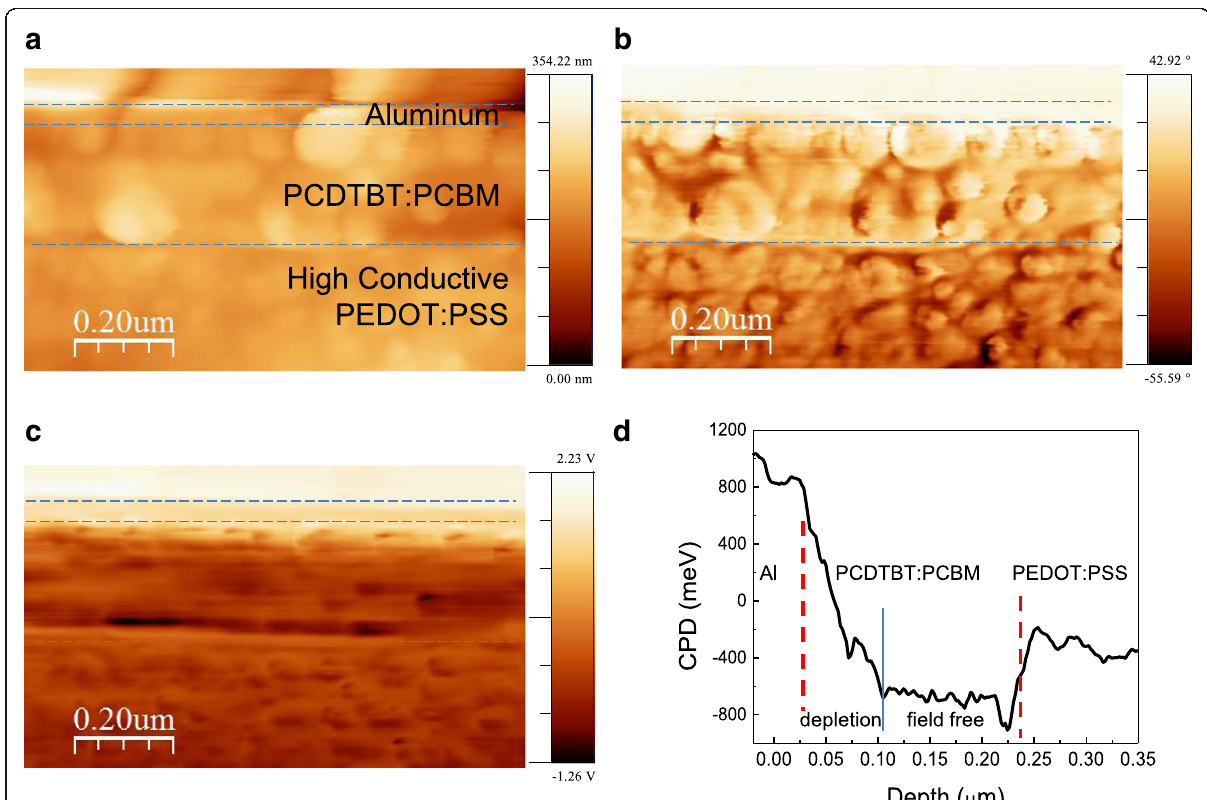
Fig. 3 Simultaneously obtained cross-sectional images of a topography, b phase, c CPD, and d mean field potential line profile obtained by spatial averaging of c . Dotted lines are guides for layer